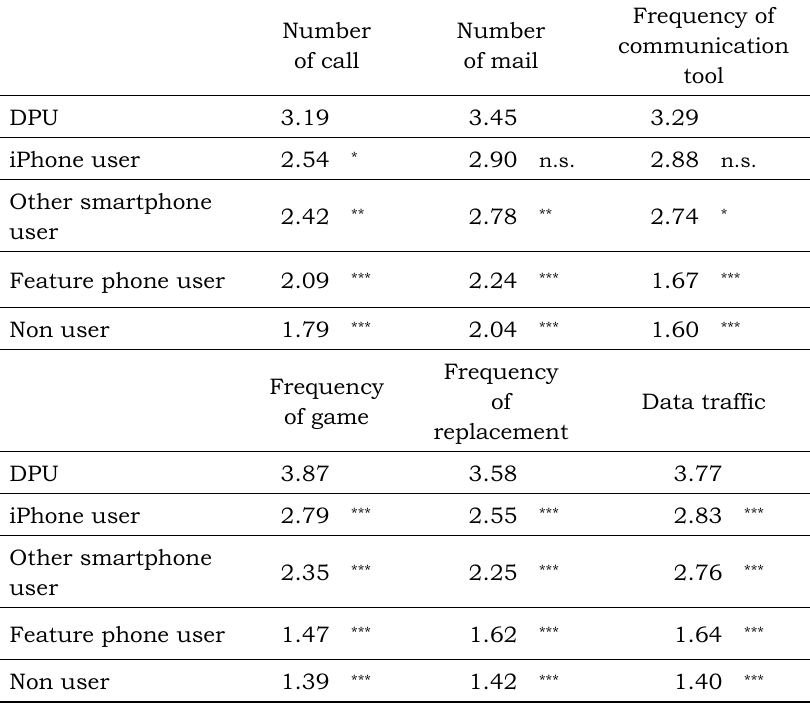
Table 3. The average of use